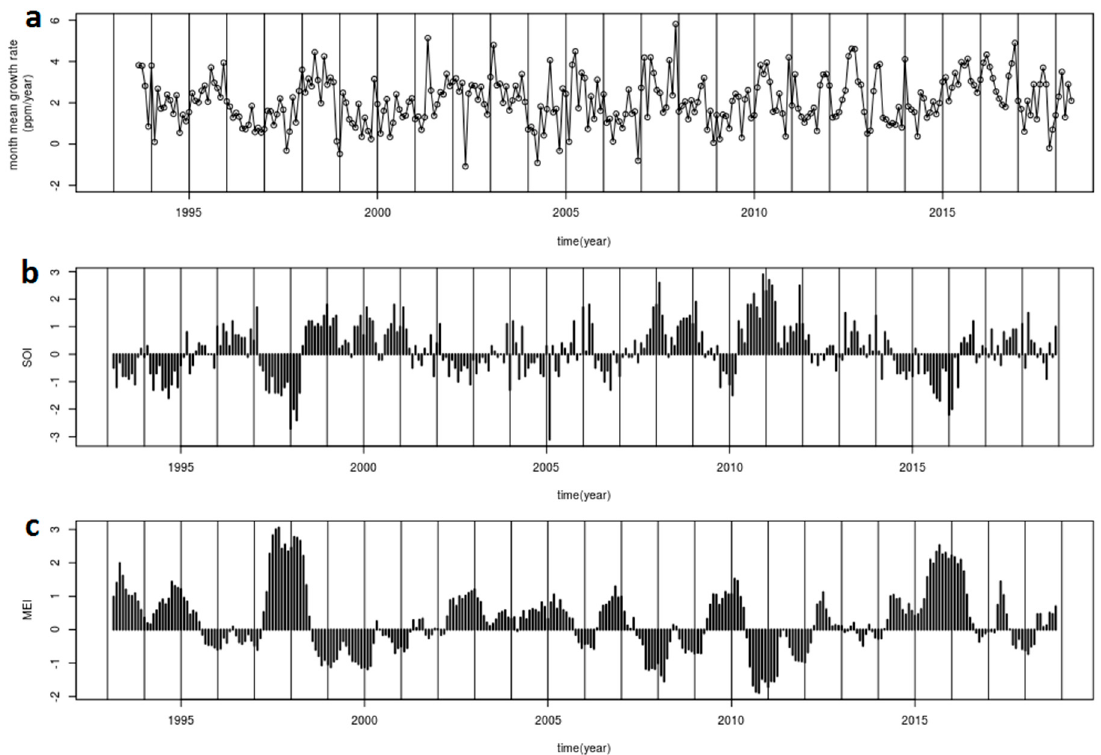
Figure 13. Monthly mean growth rate of the monthly CO 2 background PRS series ( a ), SOI ( b ), MEI ( c ).